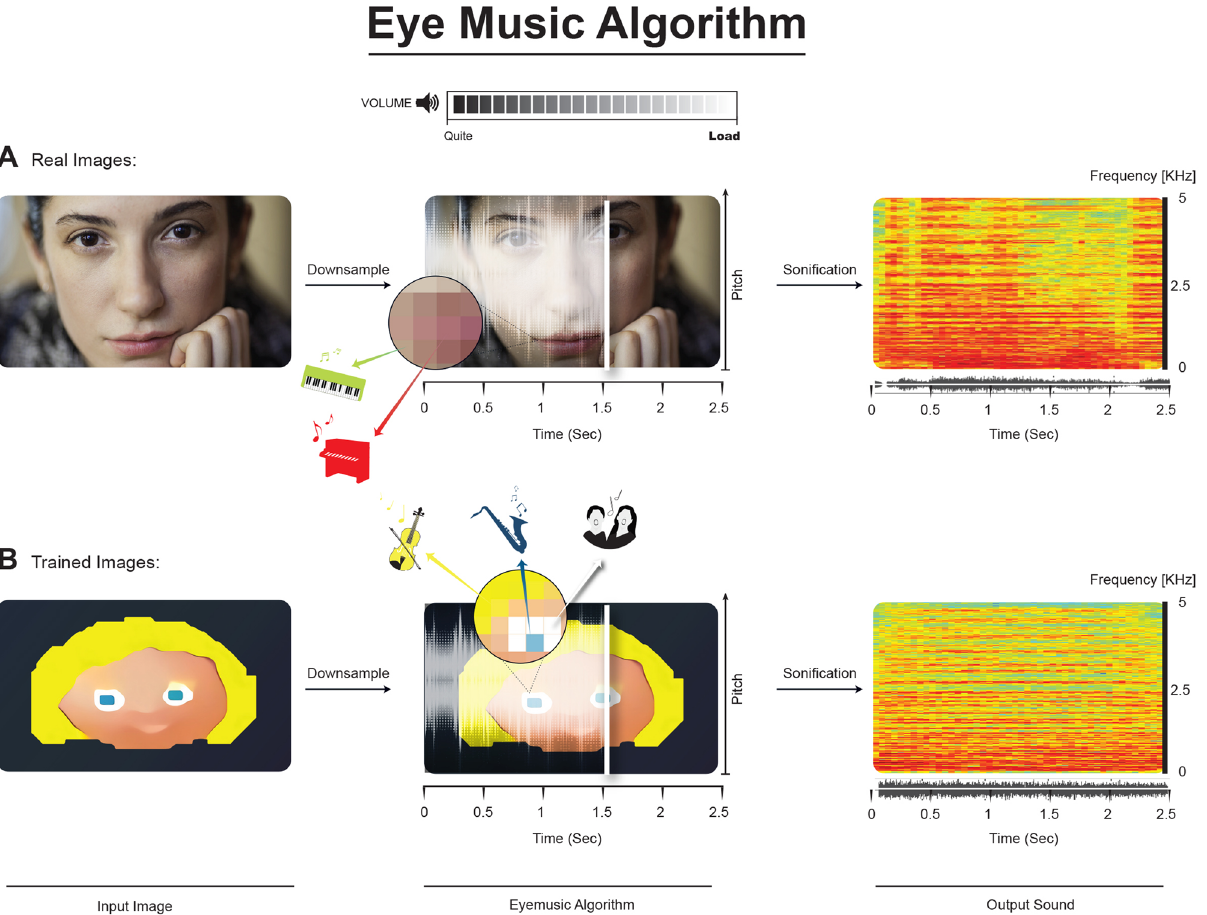
Figure 1. Training congenitally blind adults’ auditory identification of cartoon faces. Eye-Music transformation algorithm: Each image is scanned from left-to-right using a sweep-line approach so that the x-axis is mapped to time (i.e., characters positioned more on the left of the image are heard first). After downsampling the image to the EyeMusic’s resolution (50 × 30 pixels) the y-axis is mapped to the frequency domain using the pentatonic scale, such that parts of a character which appear higher in the image will be sonified with a higher pitch. Color is mapped to musical instruments. Red, white, blue, yellow, and green are transformed into organ notes, choir, brass instruments, string instruments, and reed tones, respectively. ( A ) An example of a real face transformed via the EyeMusic algorithm. ( B ) An example of a trained (cartoon) image transformed via the EyeMusic